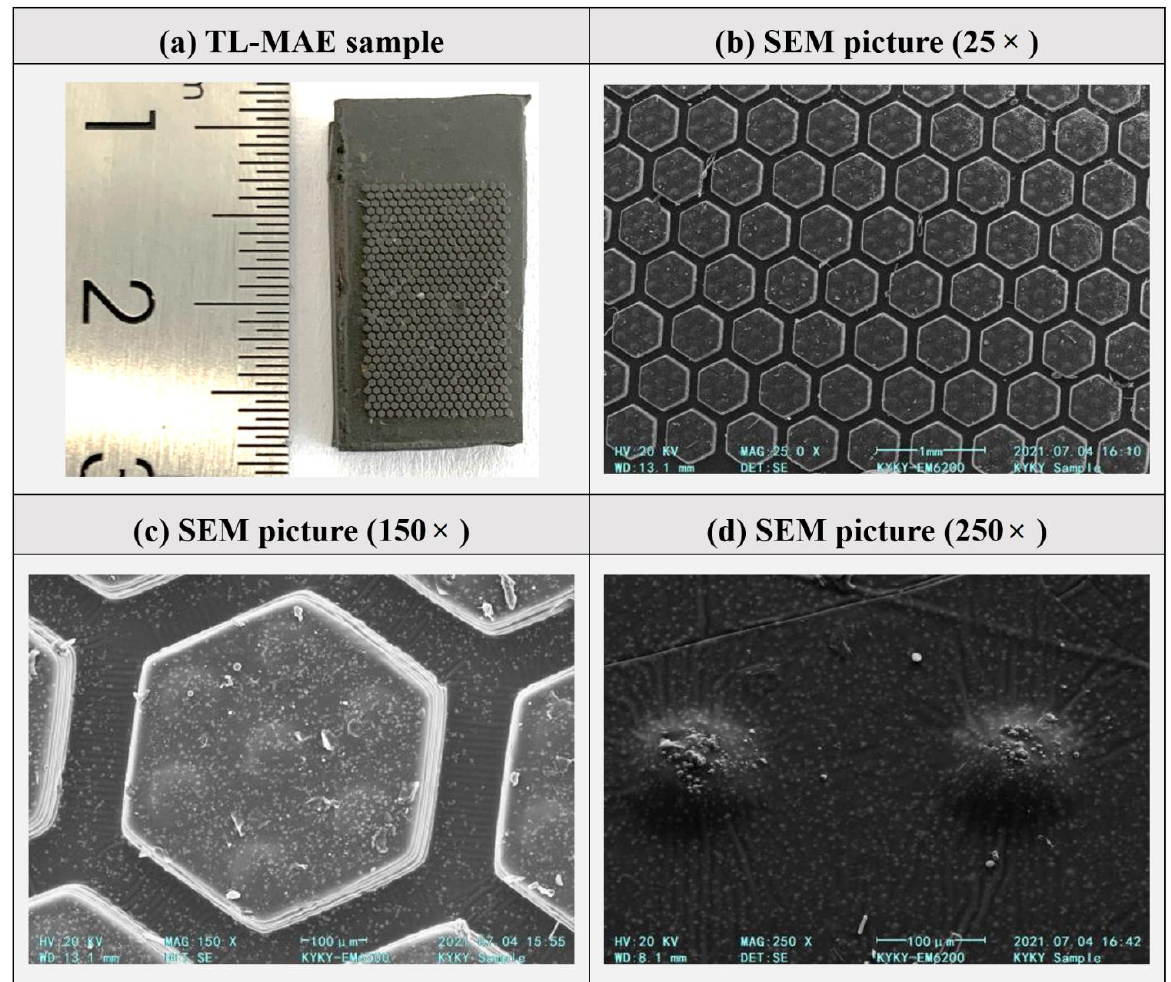
Figure 4. Surface morphologies of a 2L-MAE Sample. ( a ) the 2L-MAE sample ( b ) SEM picture (25×) ( c ) SEM picture (150×) ( d ) SEM picture (250×).